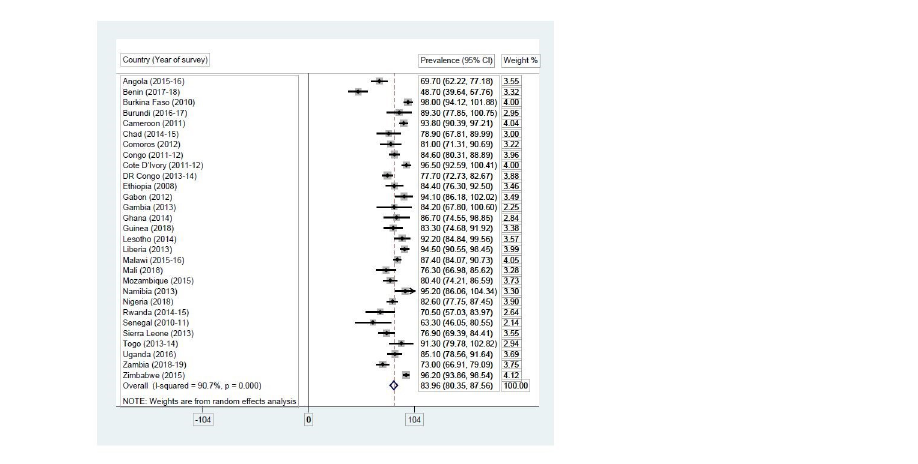
Fig 1. Proportion of men who consistently use condom during paid sex in